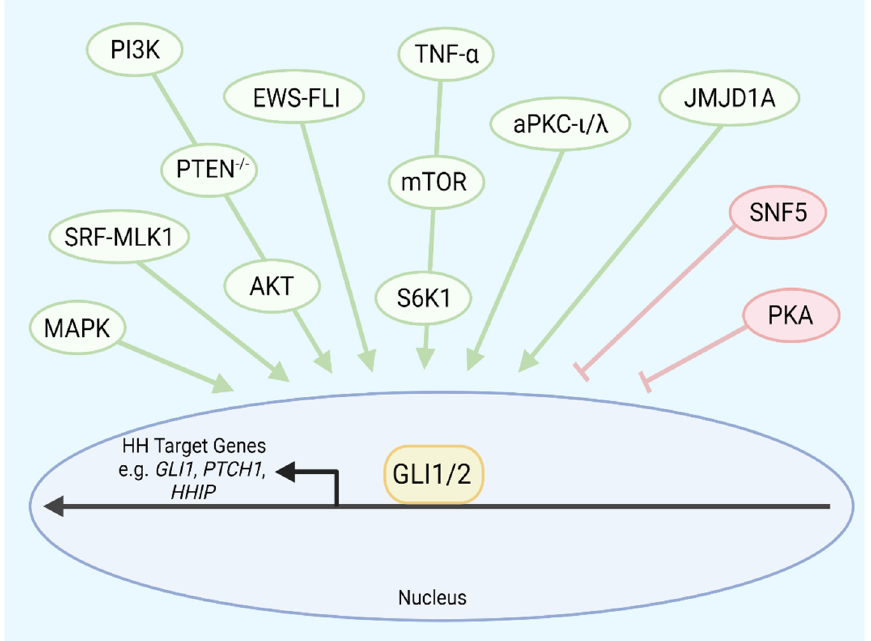
Figure 2. A simplified schematic of regulators of noncanonical GLI activation. Positive (green) and negative (red) regulators of the GLI1 and GLI2 independent of the canonical Hh pathway are shown. Crosstalk between each of these modulators and GLI1/2 bypasses the canonical Hh ligand to PTCH to SMO cascade. Abbreviations: MAPK, mitogen-activated protein kinase; SRF-MKL1, serum response factor-megakaryoblastic leukemia 1; PI3K, phosphoinositide-3-kinase; PTEN, phosphatase and tensin homolog; EWS-FLI, Ewing Sarcoma-Friend Leukemia Integration 1; TNF- α , Tumor necrosis factor α ; mTOR, mammalian target of rapamycin; S6K1, S6 kinase beta-1; aPKC- ι / λ , atypical protein kinase C ι / λ ; JMJD1A, Jumonji domain-containing histone demethylase 1A; PKA, protein kinase A. Created with